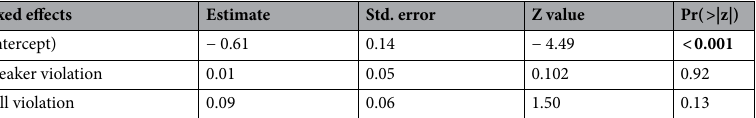
Table 8. Summary of Frequentist Logistic Linear Mixed Effects Model for Experiment 2 with congruent as the reference level. Significant values are in bold.